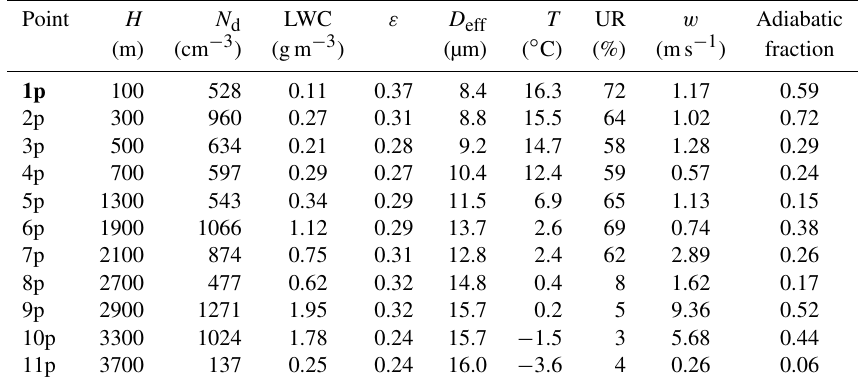
Table 3. Properties of the points highlighted in Fig. 8 for flight AD2. H is shown as the average of each of the 200m vertical bins. The adiabatic fraction is defined as the ratio between the observed and adiabatic